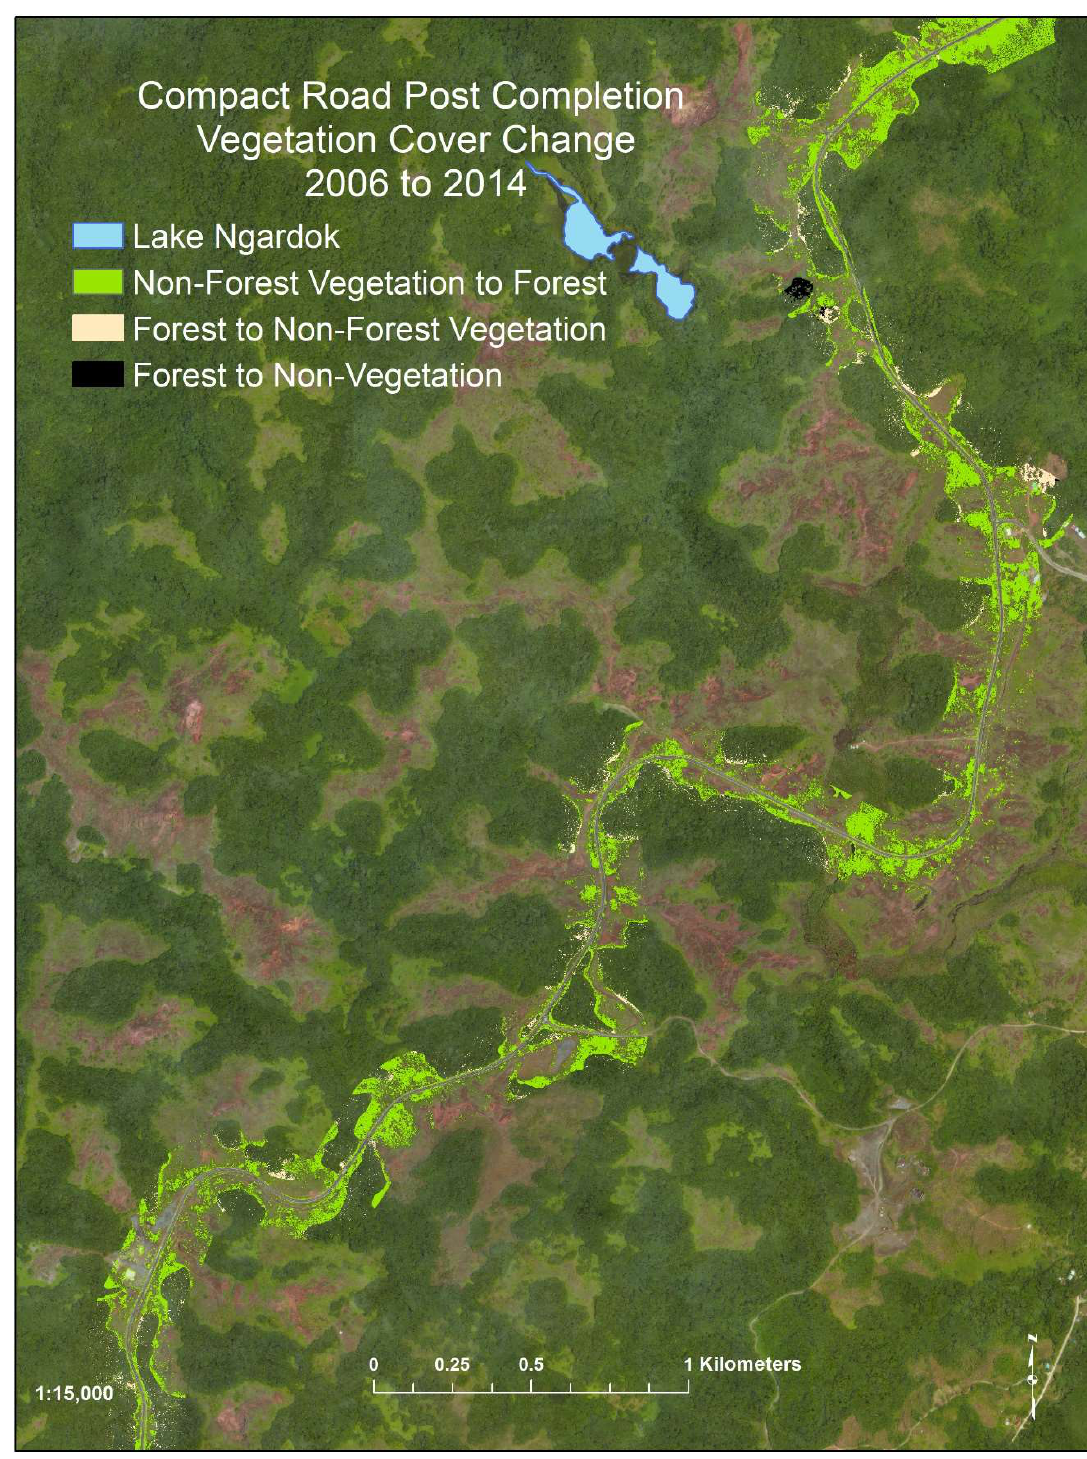
Figure 8. A 10× zoom view of Babeldaob Island, Palau showing forest, non-forest vegetation and non-vegetation cover changes within a 120 m full buffer of the Compact Road south of Lake Ngardok in Melekeok State between 2006 and 2014, overlaying the WorldView-2 2016 satellite image base map. Mapped non-forest vegetation cover decreased by 13% of the total island area from 1947 to 2014, after increasing by 16% from 1921–1947. The gains and losses of non-forest veg- etation from 1921–1976 correspond closely with losses and gains in forest cover, indicating long-term transitions between the two